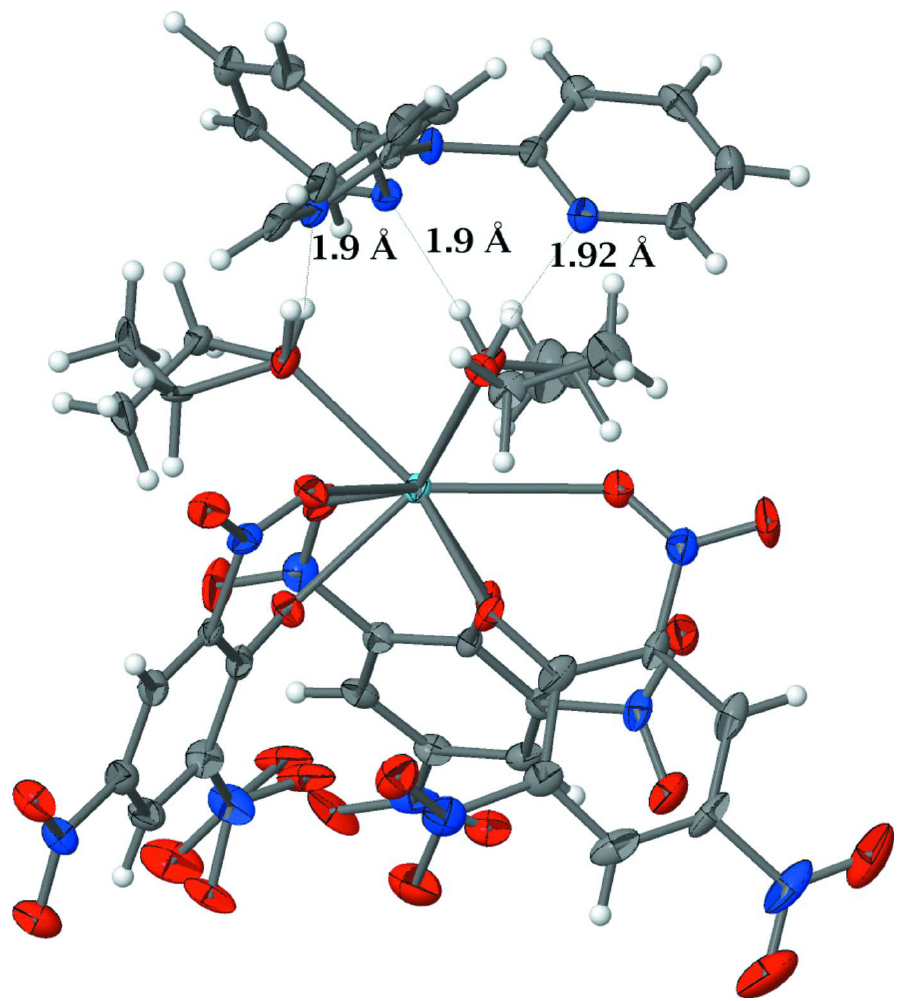
Figure 1 View of the molecular structure of (I) depicting the tris(2-pyridyl)amine molecule interacting with the (C O , O′ ) (C H O- O ) La(III) adduct through O—H···N hydrogen bonds. 50% probability displacement ellipsoids are shown 3 2 6 3 for non-H atoms. Enhanced figure is accessible at http://submission.iucr.org/jtkt/serve/ z